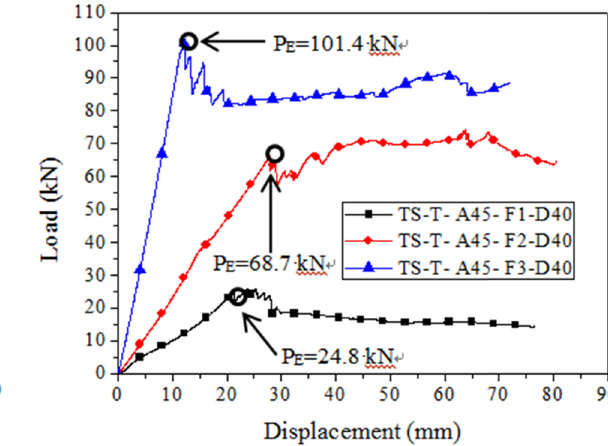
Figure 17: Displacement – load curve of specimens.